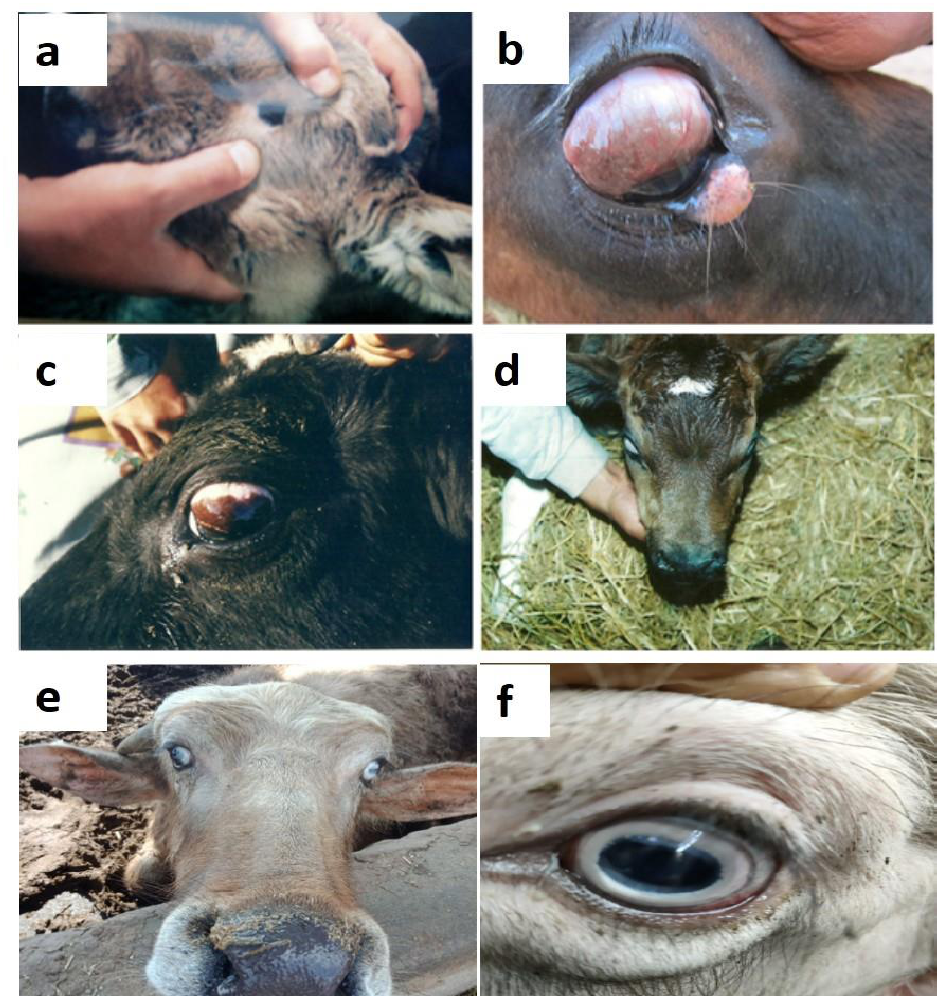
Fig. 1: Gross pictures showing congenital ocular malformations in bovine calves: anophthalmia (a), dermoid (b), unilateral strabismus (squint) with